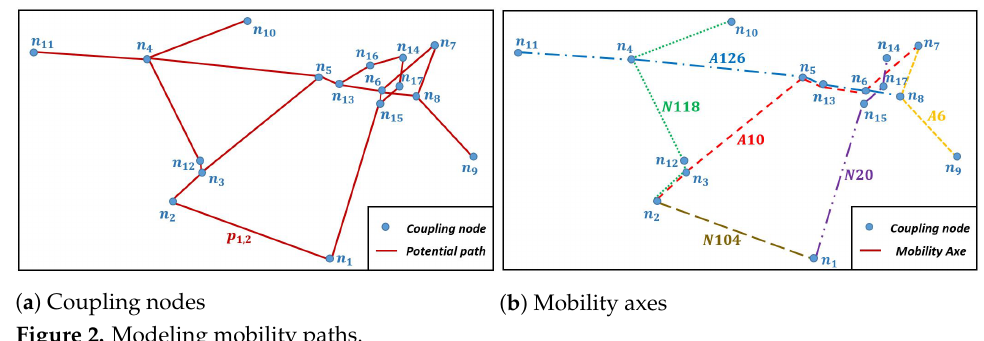
Figure 2. Modeling mobility